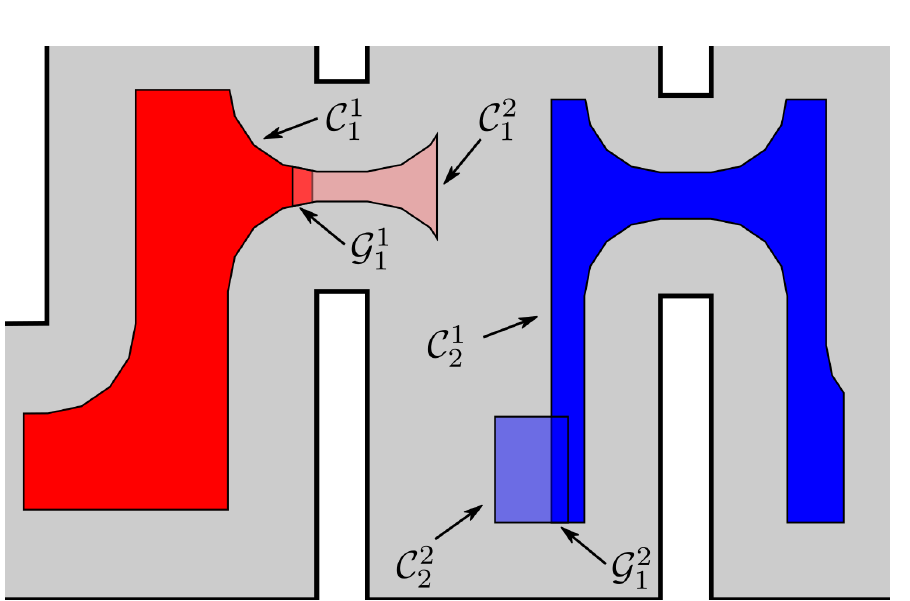
Figure 4. Two adjacent compound cells (cid:98) C 1 = ( C 1 robot 2) to successfully move from C 1 (resp., G 2,1